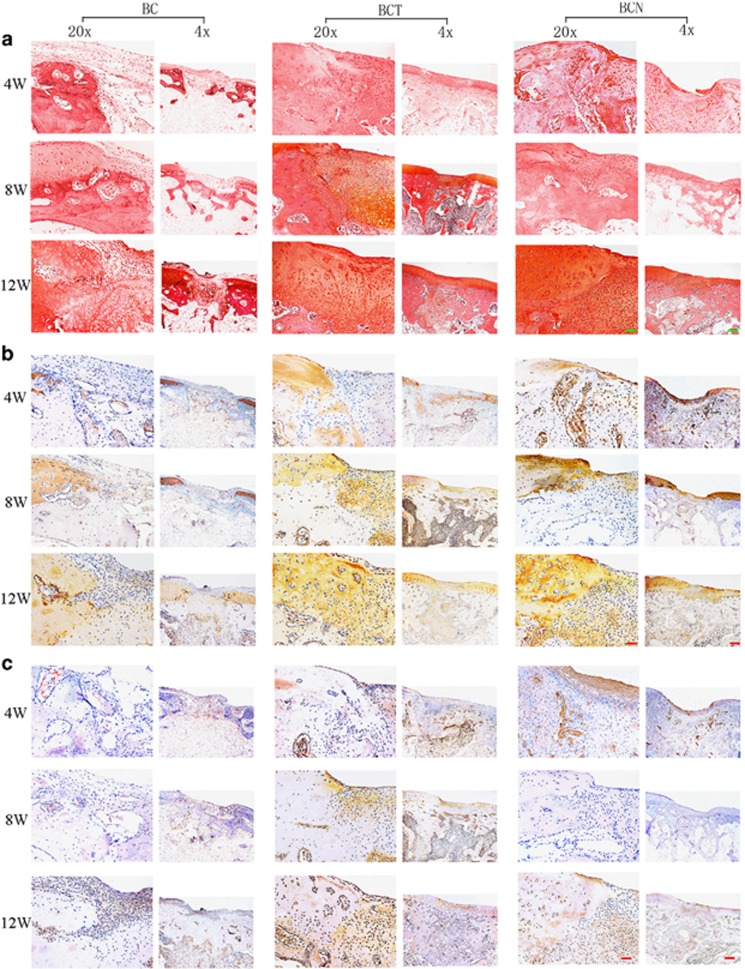
Chondrogenic effects of NGF on BMSCs in vivo. (a) Safranin O staining were performed on cartilage sections. (b and c) Immunohistochemical staining of COL1A2 (b) and COL1A1 (c) were performed in cartilage sections. (Original low magnification × 40 (scale bar, 500 μm); original high magnification × 200 (scale bar, 100 μm))